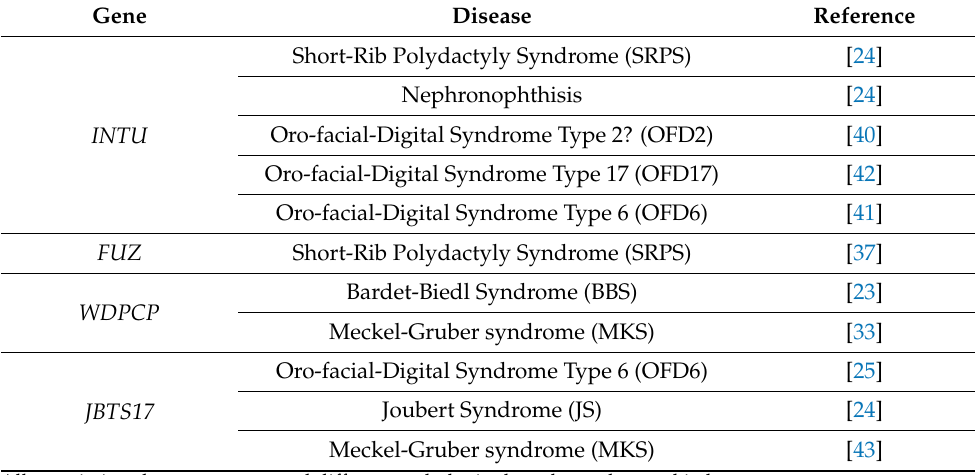
Table 1. Ciliopathies related to CPLANE complex genes. Gene